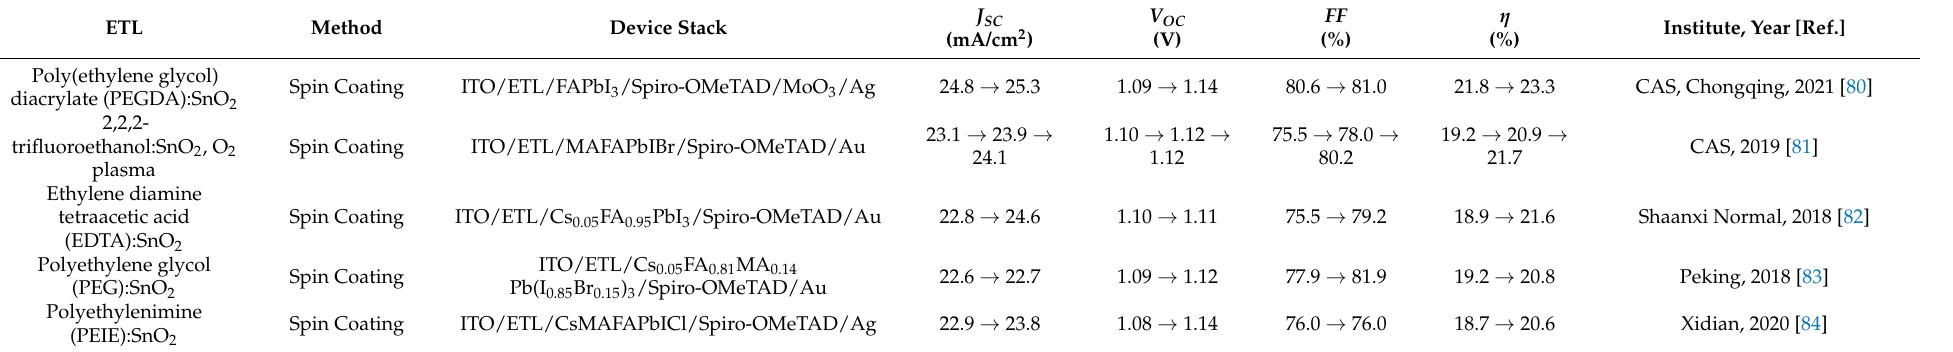
Table 8. Summary of perovskite-solar cells based on bulk incorporation of organic molecules into SnO 2 ETL.